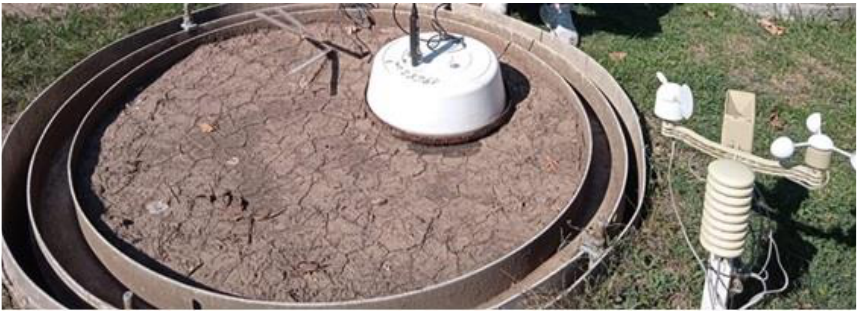
Figure 3. The setup of the frame – bowl method to measure the CO 2 efflux from undisturbed soil under field conditions.